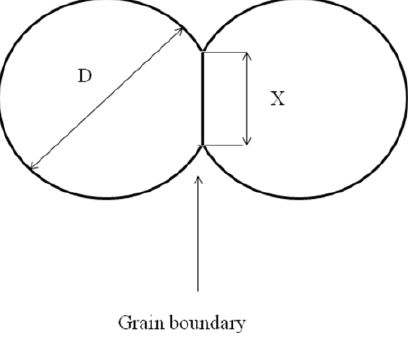
Figure 5. Sketch of a model of the sintering of two particles. D = cross-sectional area of the particle; X = neck